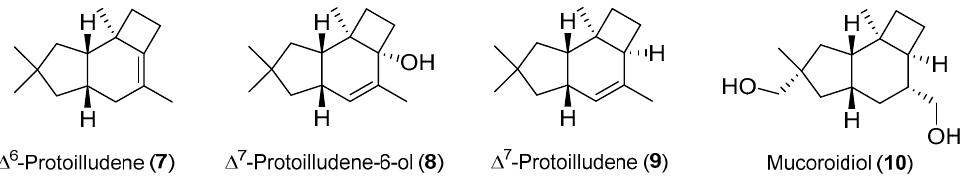
Figure 4. Structures of protoilludanes 7 – 10 isolated from the Fomitopsis and Dictyostelium genera.